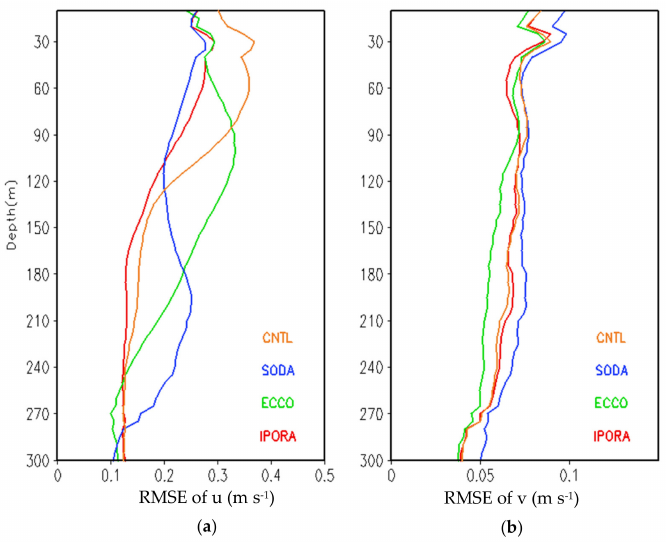
Figure 10. Vertical distribution of the RMSEs of zonal ( a ) and meridional ( b ) currents from CNTL, SODA, ECCO, and IPORA with respect to the ADCP data over seven moorings in the TAO/RAMA